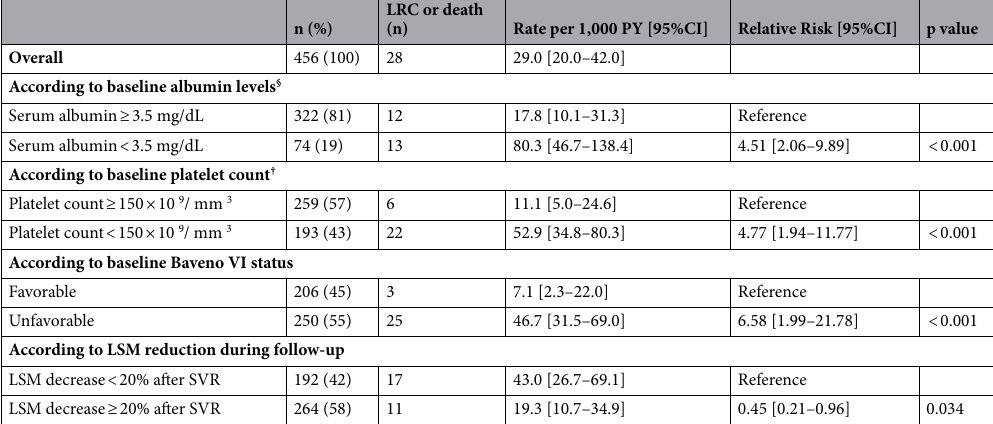
Table 2. Incidence rate [per 1,000 person-years (95% confidence interval)] of liver related complications or death in patients with hepatitis C after sustained virological response by direct-acting agents. § n = 396 patients and 25 clinical outcomes; † n = 452 patients and 28 clinical outcomes. Baveno VI status was defined as unfavorable if LSM ≥ 20 kPa or platelet count < 150 × 10 9 / mm 3 . LRC liver-related complications (ascites, hepatic encephalopathy, variceal bleeding or hepatocellular